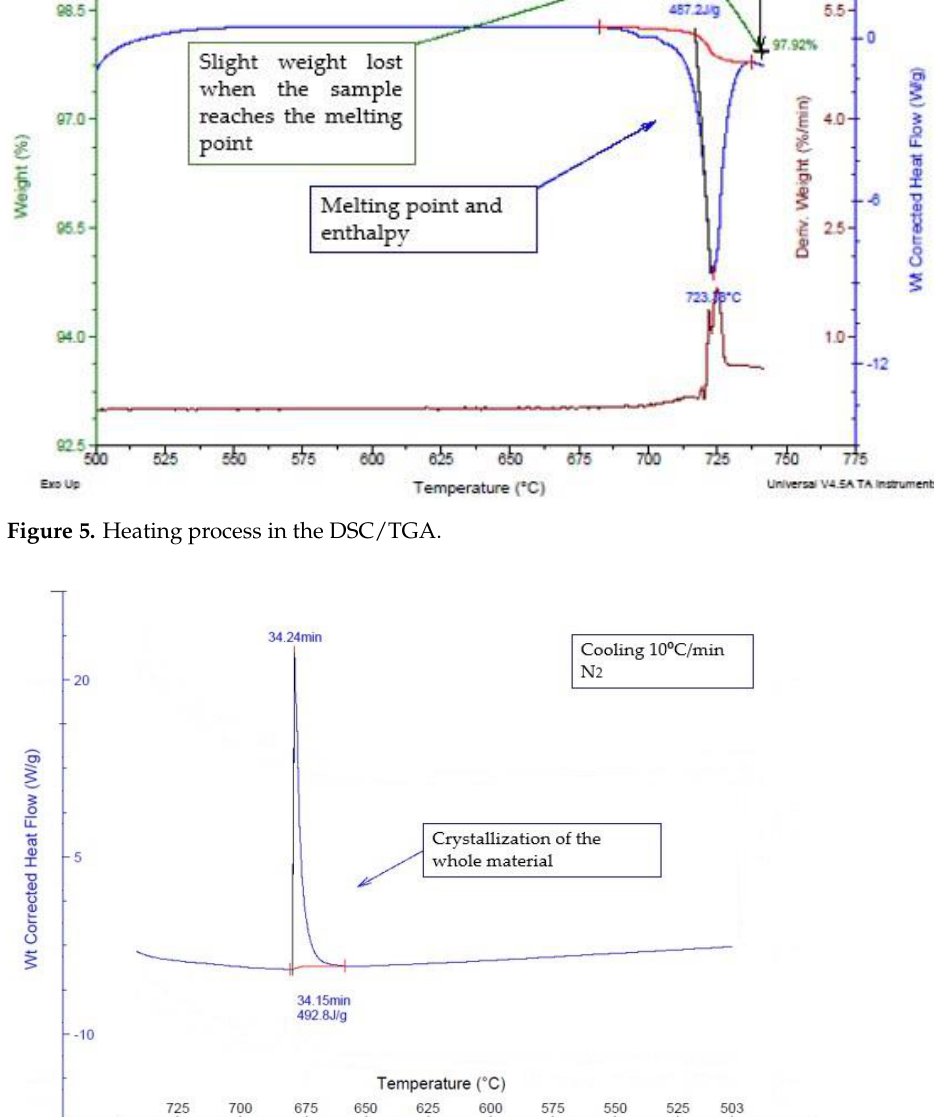
Figure 6. Cooling process in the DSC/TGA.